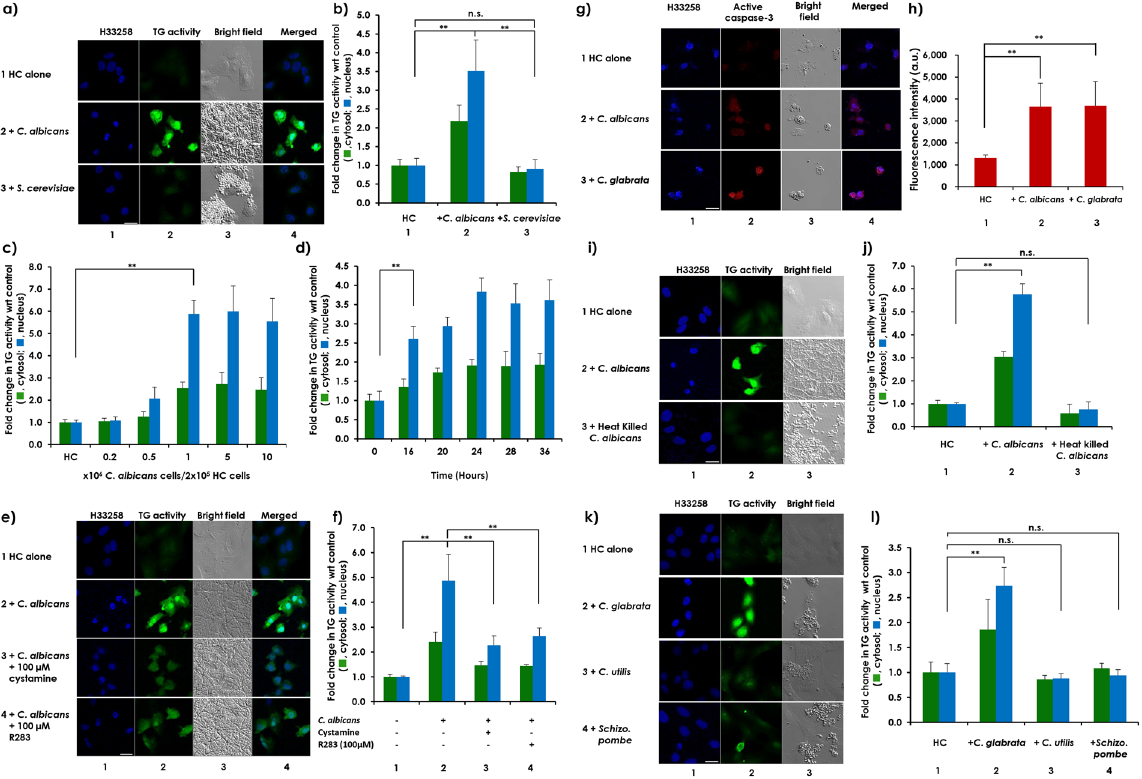
Figure 1. Cellular TG activity in HC cells increased, especially in the nucleus, upon co-incubation with pathogenic fungi. HC cells were seeded at 2 × 10 5 cells per well in a 6-well plate and incubated overnight. After adding 5-BAPA, the cells were incubated ( a ) alone (row 1) or were co-incubated with 2.5 × 10 6 C. albicans cells (row 2) or S. cerevisiae cells (row 3) for 24 hours; ( c ) with different doses of C. albicans cells for 24 hours; ( d ) with 5 × 10 6 C. albicans cells for the indicated time; ( e ) with 5 × 10 6 C. albicans cells in the absence (row 2) and presence of 100 µ M of TG2 inhibitors, cystamine (row 3) or R283 (row 4) for 24 hours; ( g ) alone (row 1) or were co-incubated with either 5 × 10 6 C. albicans cells (row 2) or the same number of C. glabrata cells (row 3) in an insert cup with a 0.4- µ m pore size; ( i ) alone (row 1) or were co-incubated with living 5 × 10 6 (row 2) or heat-killed 5 × 10 9 (row 3) C. albicans cells for 24 hours; or ( k ) alone (row 1) or were co-incubated with living 5 × 10 6 C. glabrata (row 2), C. utilis (row 3) and Schizo. pombe cells (row 4) for 24 hours. Scale bars = 20 µ m. Representative images from at least 3 fields from 3 independent experiments are shown for ( a,e,I and k ) and from at least 3 fields from a single experiment for ( g ). Fluorescence intensities from TRITC in both the cytoplasm and nucleus of panels (b,c,d,f and j) were quantitated using ZEN 2011 software, and relative TG activity levels in both locations are presented in bar graphs, with the levels from HC cells incubated alone (panels b,c,f,h and j) or at time 0 ( d ) used as the controls (mean ± SD, n = 3). Fluorescence intensities from Alexa 488 signal from panel ( h ) were quantitated using ZEN 2011 software, and the mean ± SD are presented in bar graphs after subtraction of background intensities. Asterisks represent statistical